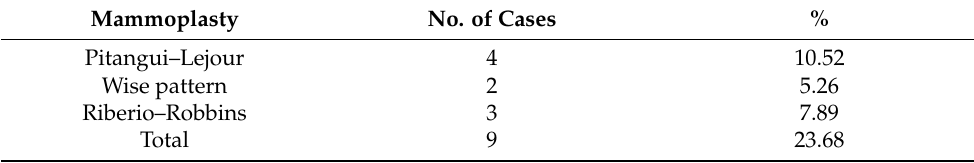
Table 3. Case classification based on the type of mammoplasty performed in Group